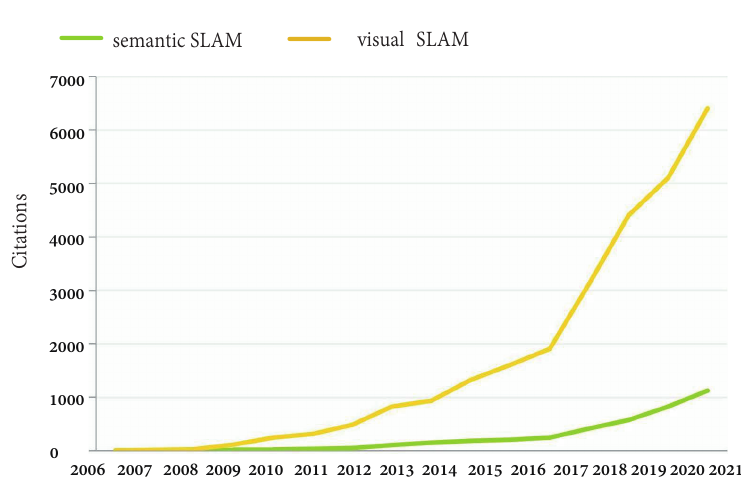
Figure 5. Citations for Web of Science articles on visual SLAM and semantic SLAM in recent years (Data are as of December 2021).